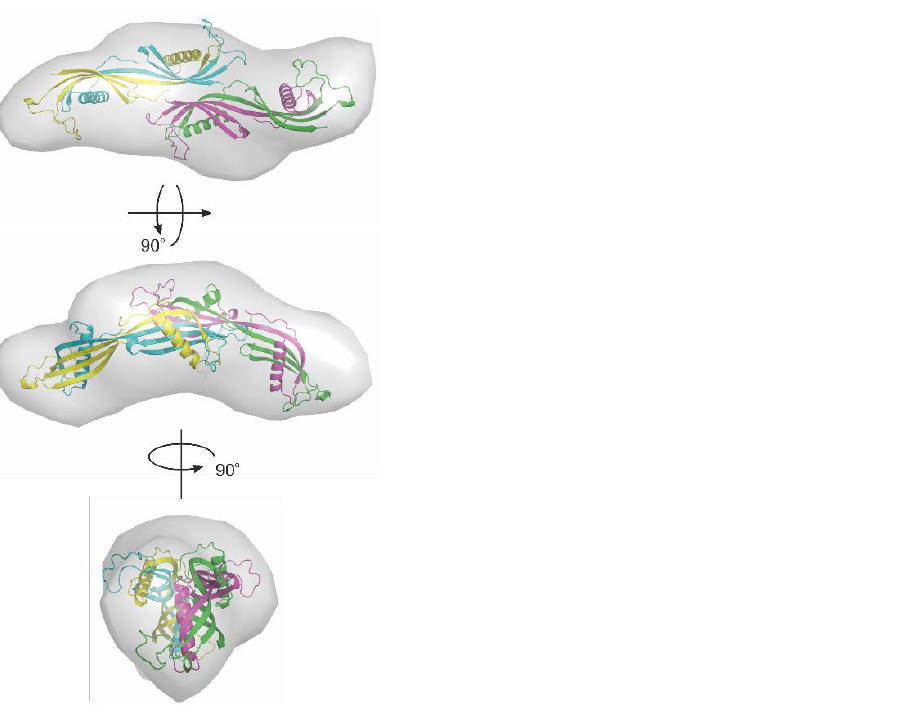
Figure 7. Low-resolution model of tetrameric HCC obtained using DAMMIF modeling and SAXS data collected at pH 3.0. Table 3. The fractions of oligomeric forms of HCC calculated from SAXS data.